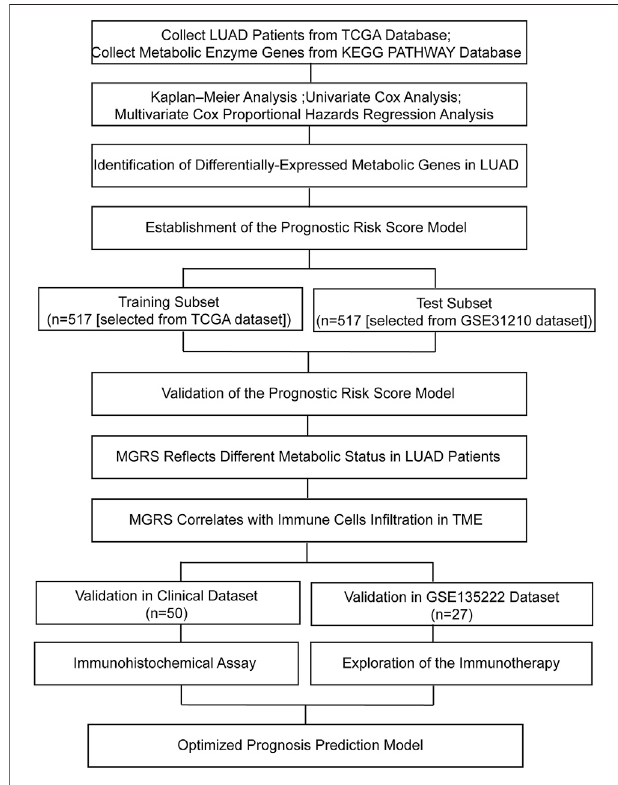
FIGURE 1 | Flow chart of this study. LUAD, lung adenocarcinoma; MGRS, metabolic genes risk score; TME, tumor microenvironment.